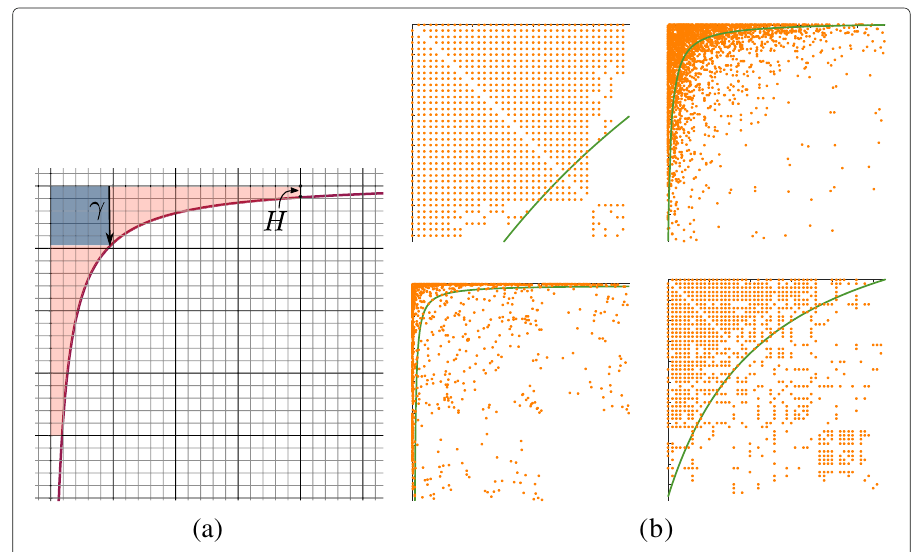
Fig. 1 Visualization of parameters for the hyperbolic model, and real-world examples. Models are shown on the degree-ordered adjacency matrix of each community. Customarily, the positive domain of the coordinate system is plotted from top left. Orange dots represent edges. The solid line visualizes the hyperbolic model. a γ and H b Examples of hyperbolic communities from (Metzler et al.